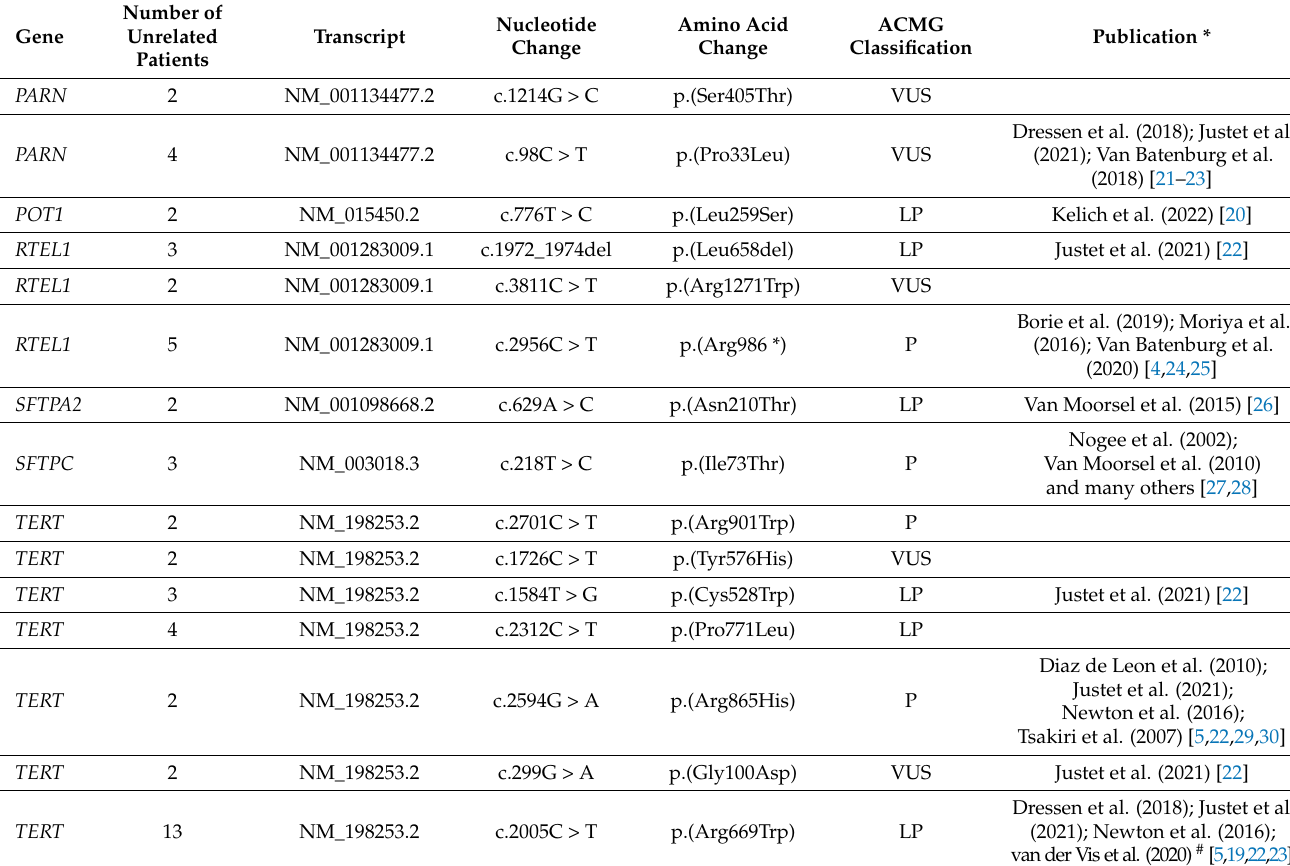
Table 1. Overlapping variants in established pulmonary fibrosis (PF)